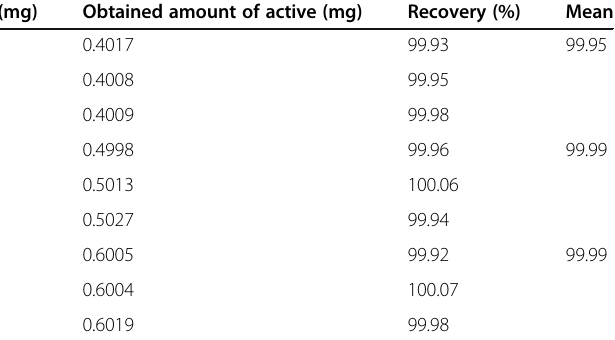
Table 1 A system-generated cumulative result of accuracy study of entecavir No. Concentration of sample Theoretical amount of active